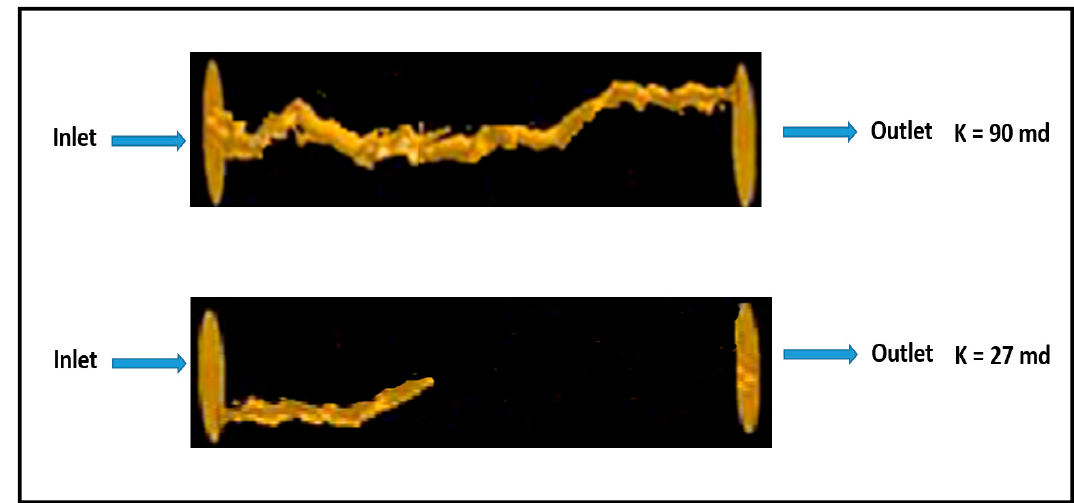
Figure 1. CT-scan images for the rock samples after acidizing treatment without using thermochemical fluids (no acid diverter).